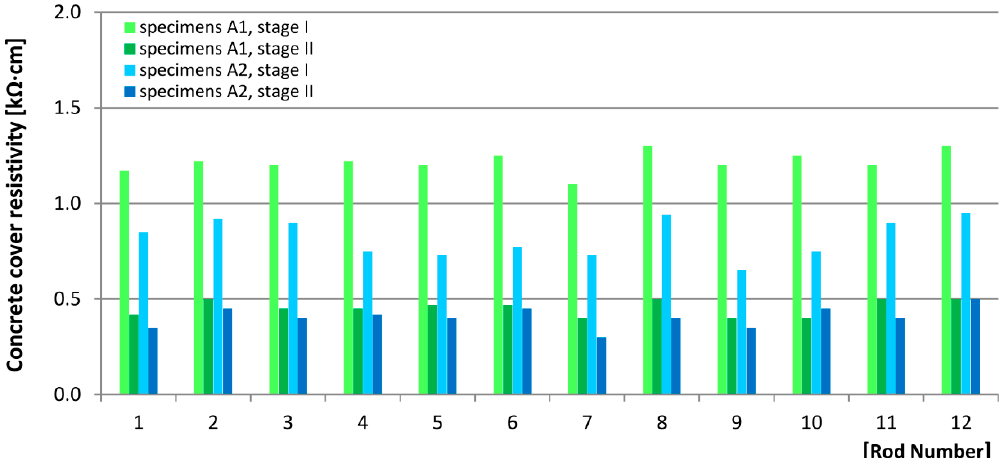
Figure 10. Results of the measurements of the concrete cover resistivity.